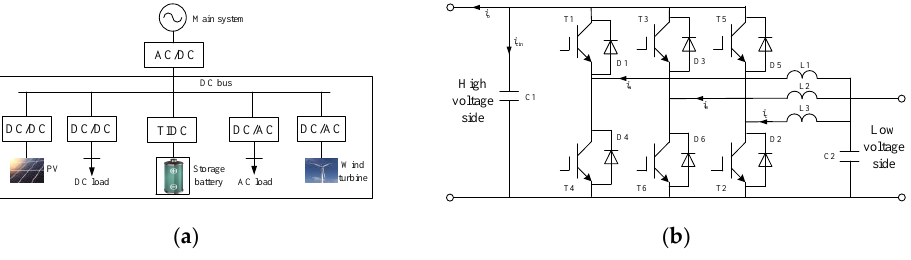
Figure 1. The Three-Branch Interleaved DC-DC Converter (TIDC) in DC microgrid: ( a ) a typical structure of DC microgrid; and ( b ) the topology of the TIDC.